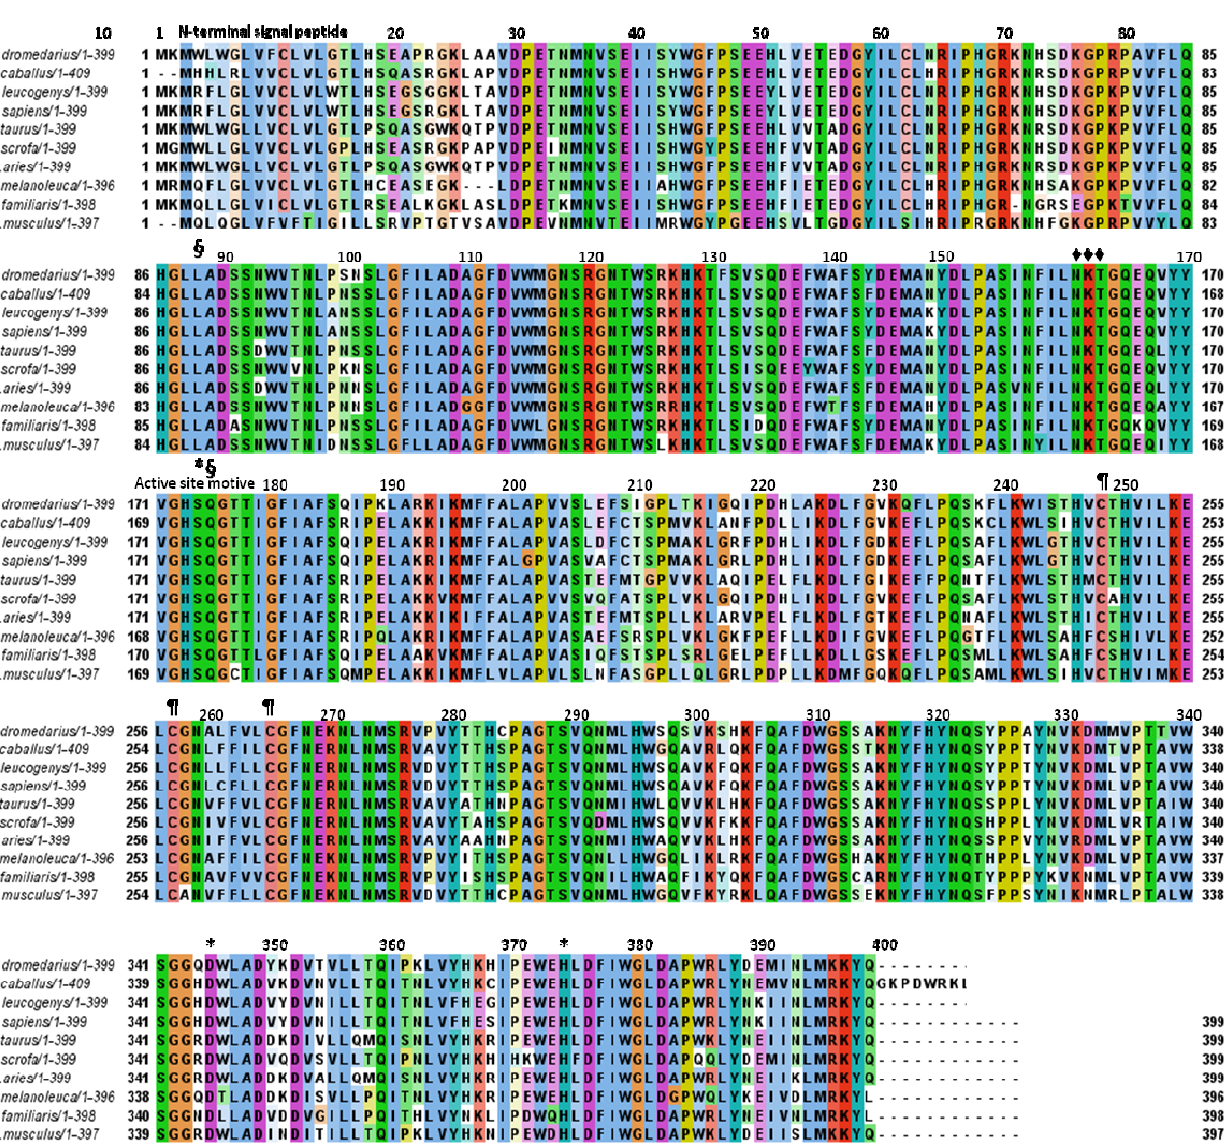
Figure 3. Aminoacid sequence alignment of cLIPA and potentially related proteins from the GenBankTM database. The alignment was generated with the MAFFT Multiple Sequence Alignment program [18]. The first 21 aminoacids represents the signal sequence and the active protein starts from aminoacid number 22. The aminoacid residues of the catalytic triad of the enzymes (Ser 174 , His 374 and Asp 345 ) are marked by *, the oxyanion hole (Gln 175 and Leu 88 ) by § and the potential glycosylation sites (Ans 161 , Lys 162 , Thr 162 ) by ♦ and the cysteine residues (Cys 248 , Cys 257 , Cys 265 ) by